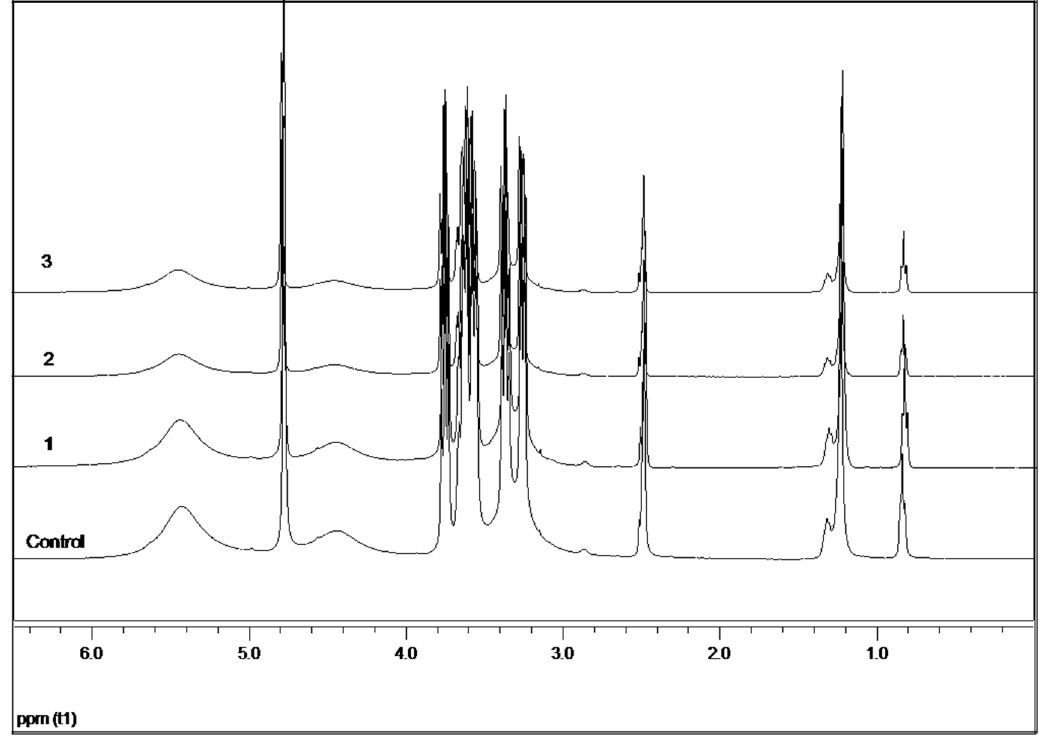
Figure 8. 1 H-NMR spectra of IC conjugated with AuNPs, before and after irradiation. The irradiation conditions for each spectra were: Control (without irradiation), 1 (250 mW/15 min), 2 (450 mW/ 15 min), and 3 (450 mW/60 min).